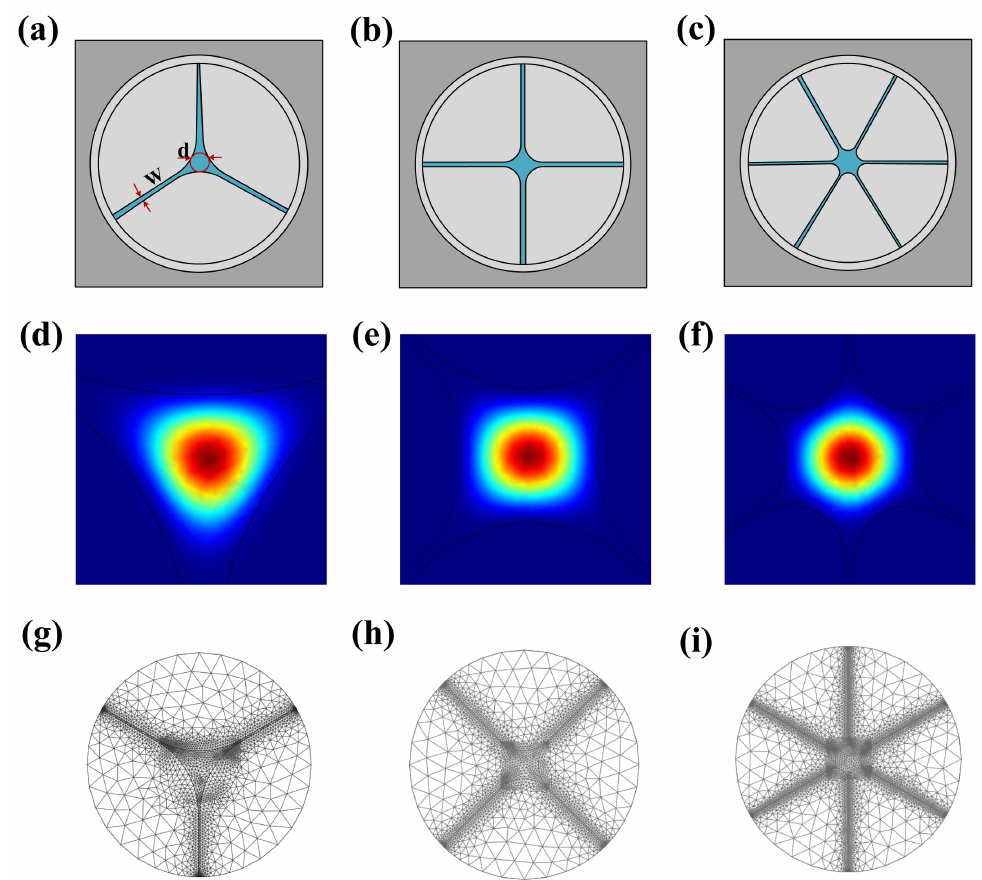
Figure 1. ( a – c ) Cross section of the core area for simulation with three bridges, four bridges, and six bridges, respectively. ( d – f ) Fundamental optical mode field distribution of three bridges, four bridges, and six bridges, respectively. ( g – i ) Triangular mesh of finite element for the three brigades, four bridges, and six bridges SCF,